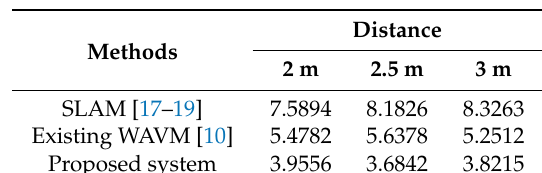
Table 1. Comparison of the root mean square error (RMSE) for the ground truth and results with methods. SLAM: simultaneous localization and